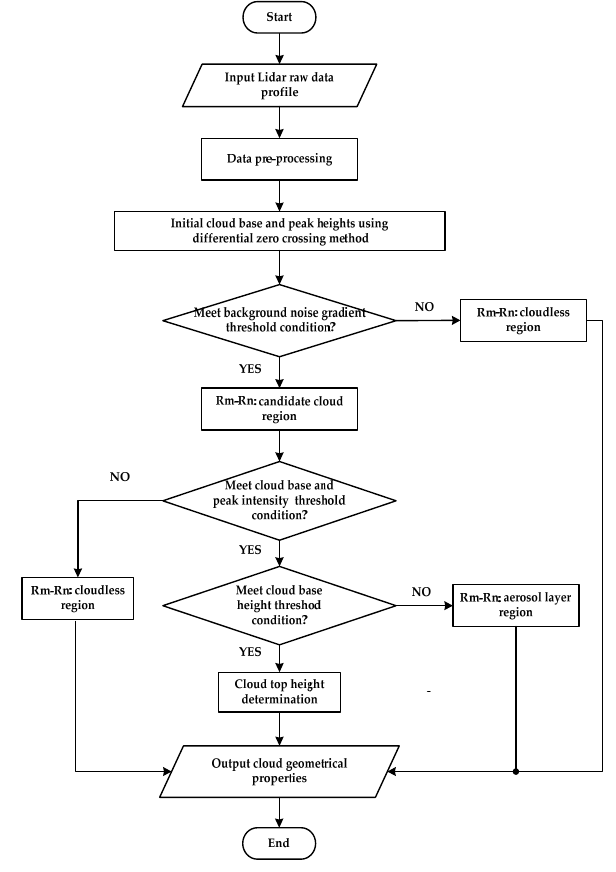
Figure 3. Flow chart of cloud properties retrieval based on improved zero-crossing method.